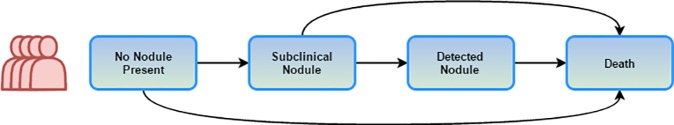
State transition diagram.